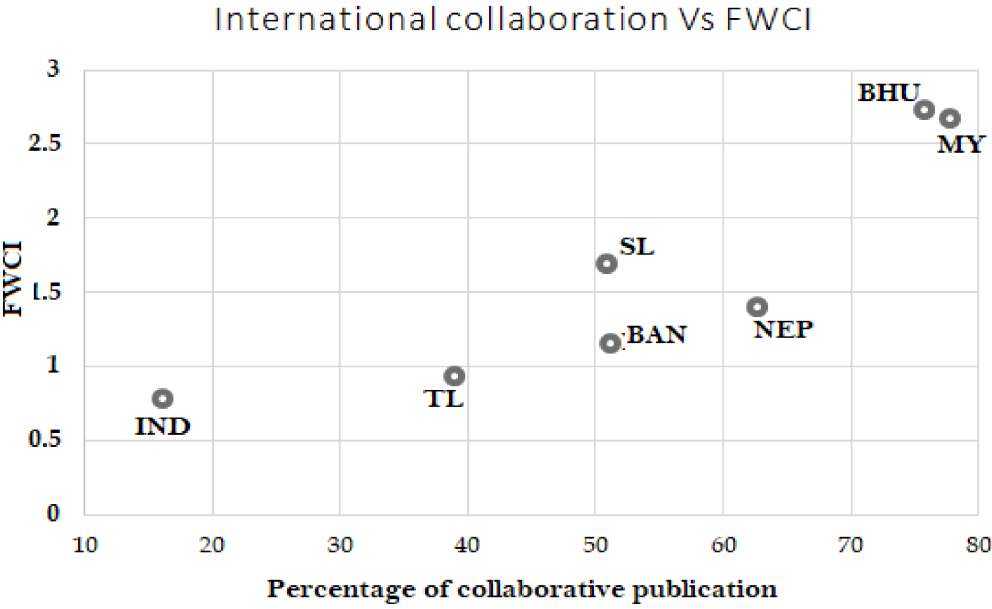
Figure 7. Comparison of FWCI with the percent of international collaborative papers. India (IND), Thailand (TL), Bangladesh (BAN), Sri Lanka (SL), Nepal (NEP), Myanmar (MY), Bhutan